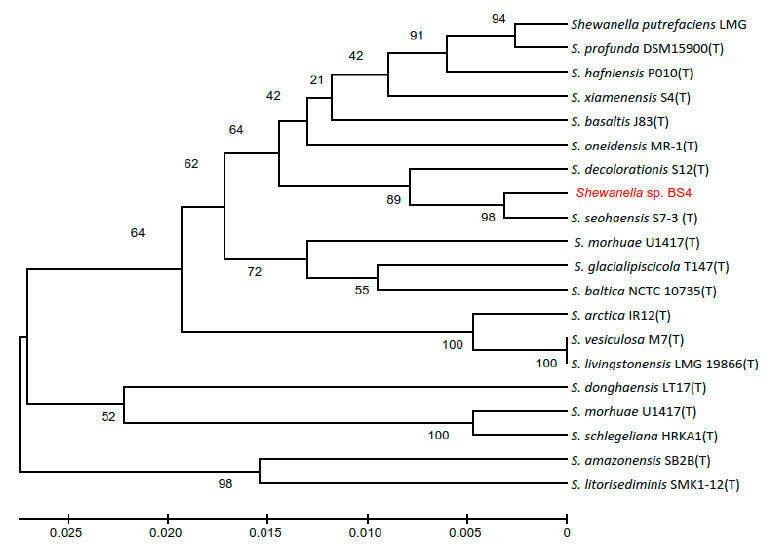
Figure 1. Phylogenetic tree showing the position of Shewanella sp. BS4 and its closest neighbors with a bootstrap value of 1000.